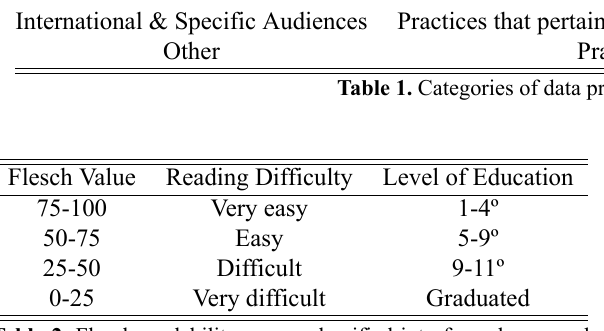
Table 2. Flesch readability scores classified into four classes and the corresponding level of education (Martins et al., 1996).